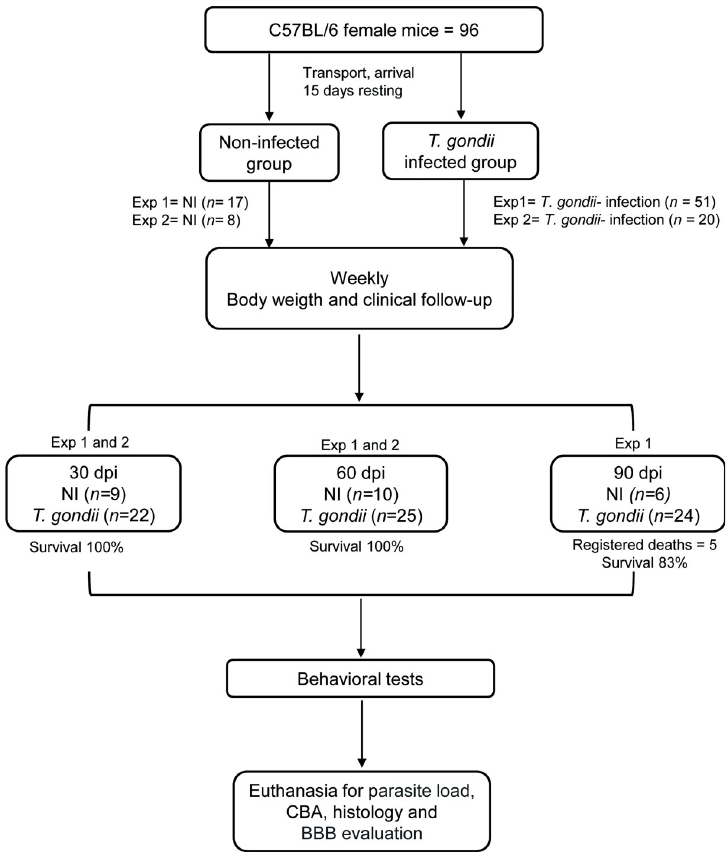
Fig 1. Flow chart showing the experimental protocol with the number of animals used. Death registered, and mice included in 2 (endpoint registered at “30 and 60 dpi”) or 1 (endpoint registered at “90 dpi”) independent experiments.